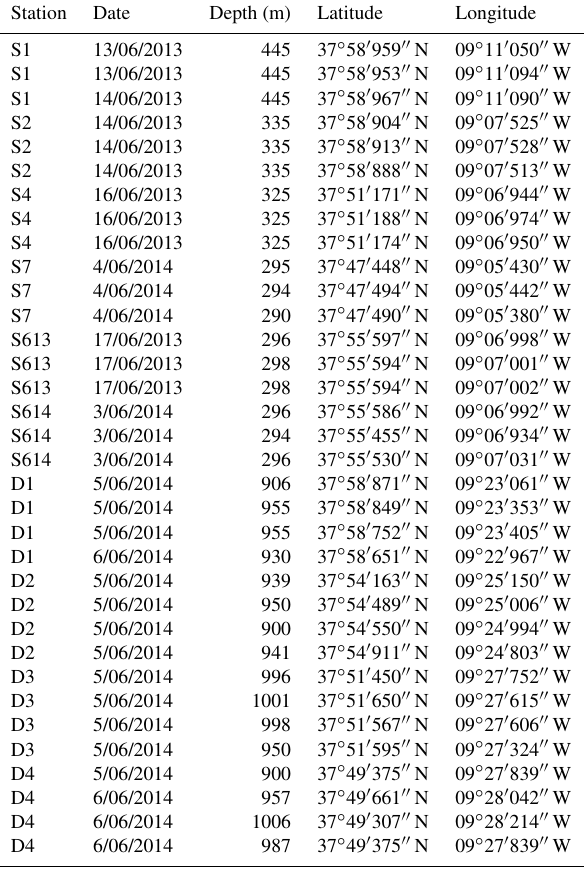
Table 1. Sampling details: station name (S refers to the “shallow transect”, while D refers to the “deep transect”), date of sampling, water depth (m), latitude, and longitude. Three and four indepen- dent replicates have been taken, respectively, at the shallow and deep stations (see Sect.